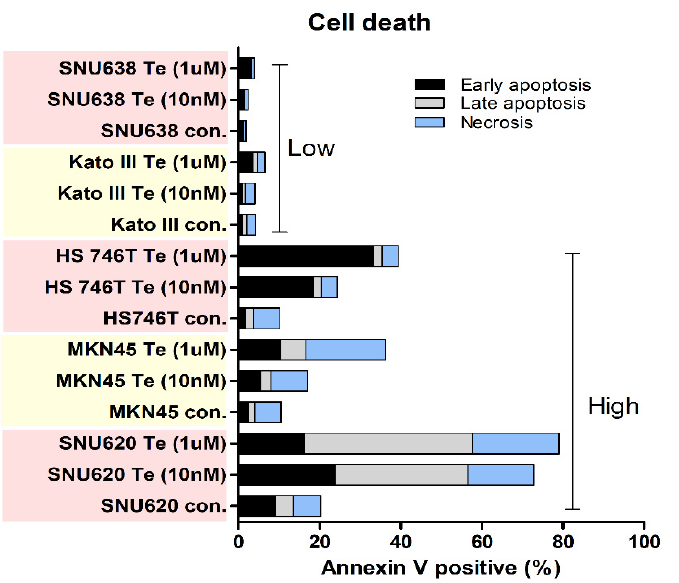
Figure 3. Effects of tepotinib on cell apoptosis and necrosis in GC cell lines. SNU638, Kato III, Hs746T, MKN45, and SNU620 cell lines were treated with 10 nM or 1 µM of tepotinib for 48 h.